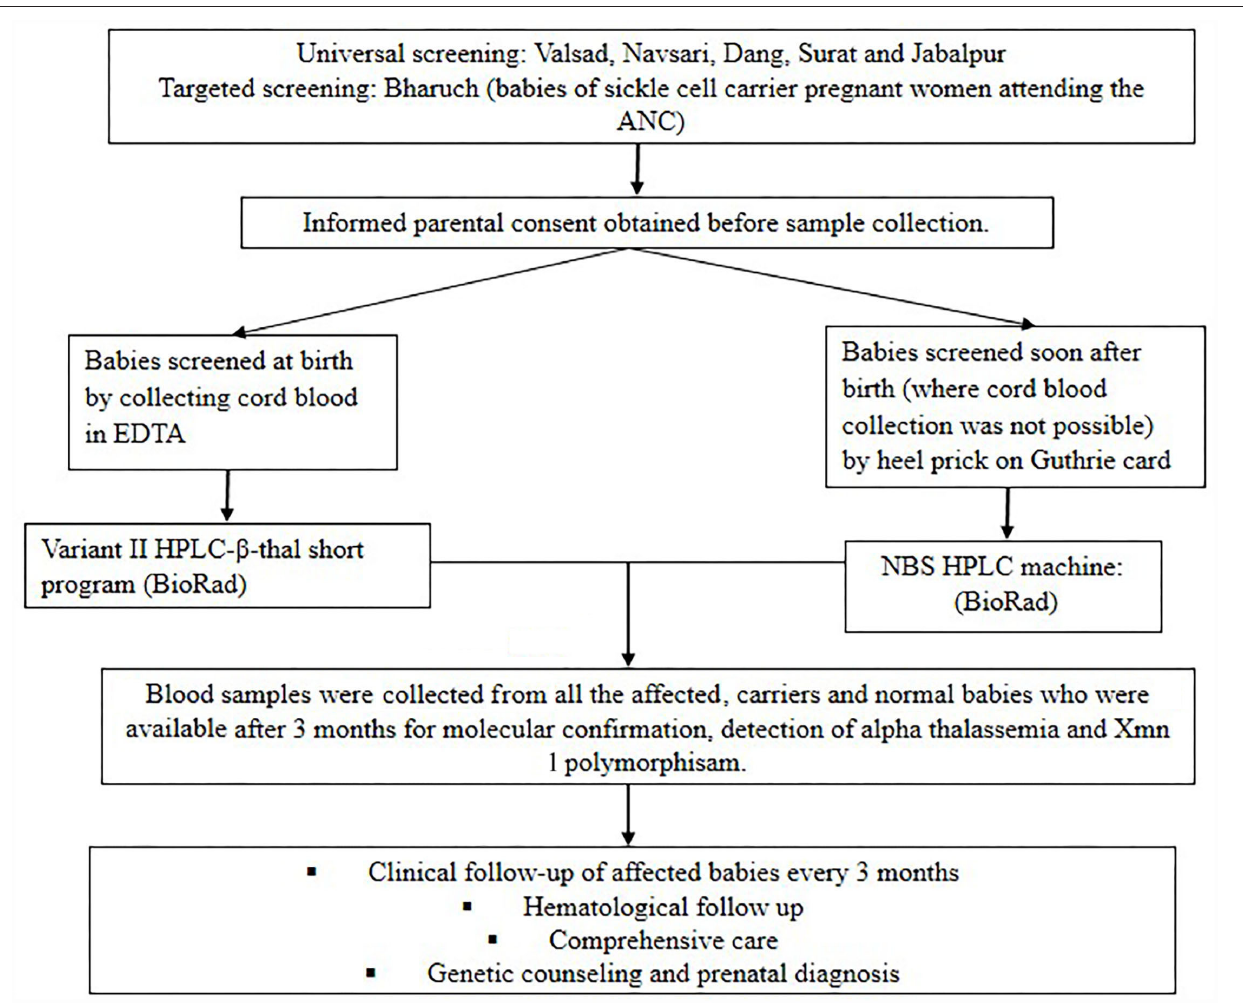
FIGURE 1 | Flow chart of